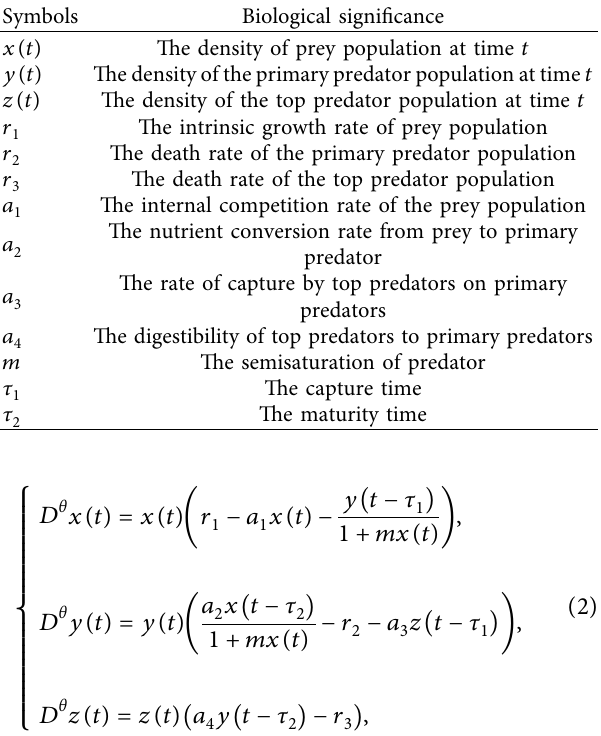
Table 1: Biological significance of